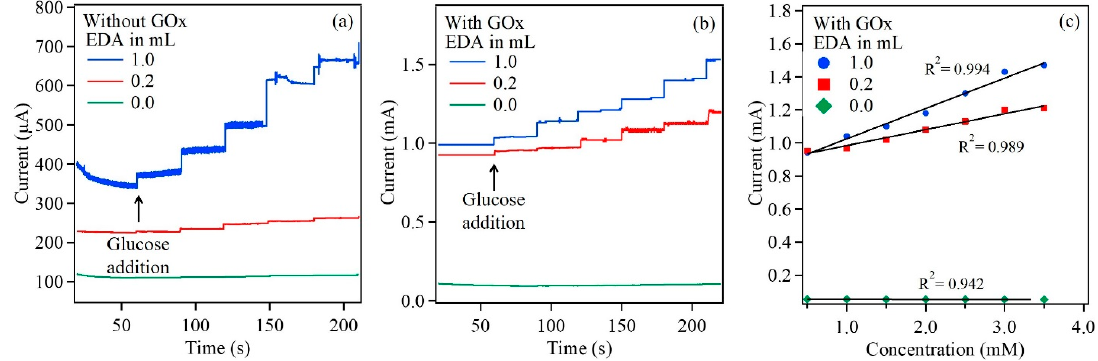
Figure 7. Amperometric response of Cu 2 O/ITO ( a ) and GOx/Cu 2 O/ITO ( b ) electrodes to glucose in 10